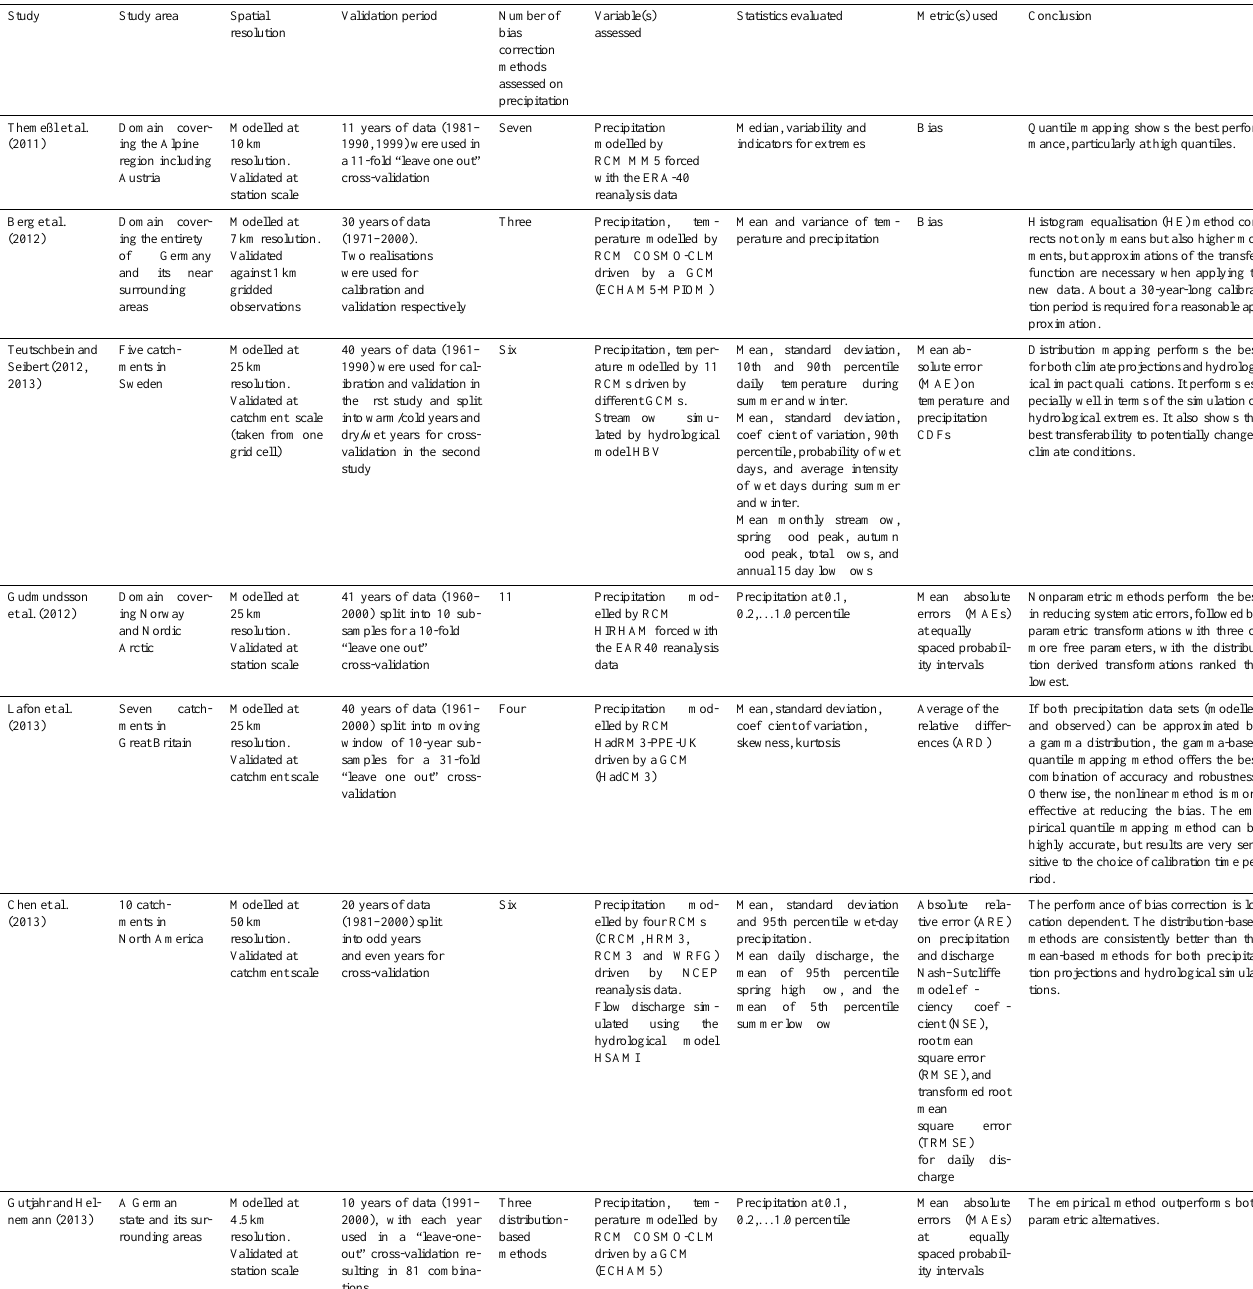
Table 1. Recent studies comparing different RCM bias correction